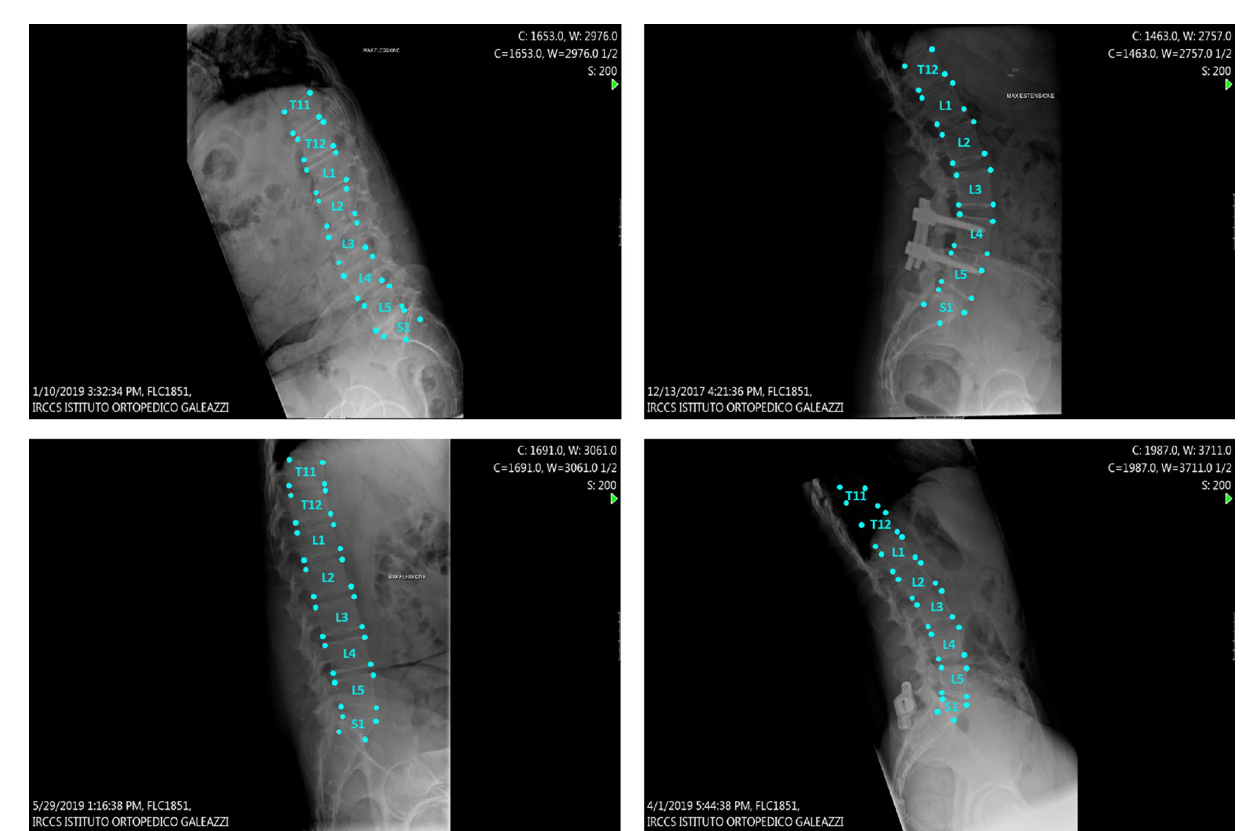
Figure 2. Four random images from the test set. These images have large black edges that do not affect the model